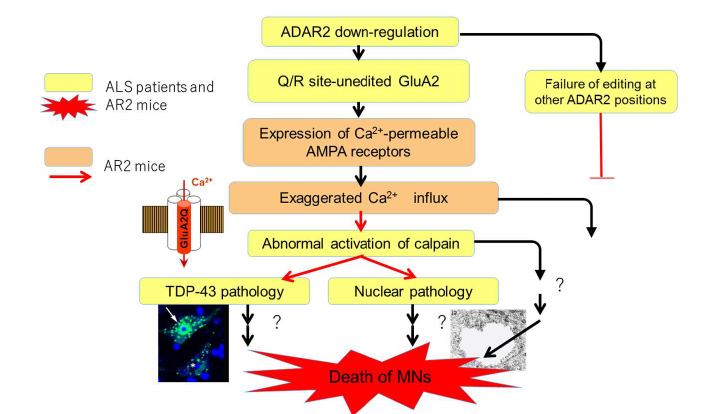
Figure 1. Cell death cascade of motor neurons in sporadic amyotrophic lateral sclerosis (ALS). Molecular abnormalities relevant to neuronal death only in conditional adenosine deaminase acting on RNA 2 (ADAR2) knock-out mice (AR2) (orange), as well as in both patients with ALS and AR2 mice (yellow) have been experimentally validated. AMPA = α -amino-3-hydroxy-5-methyl-4-isoxazole propionic acid; TDP-43 = transactive response DNA-binding protein; MNs = motor